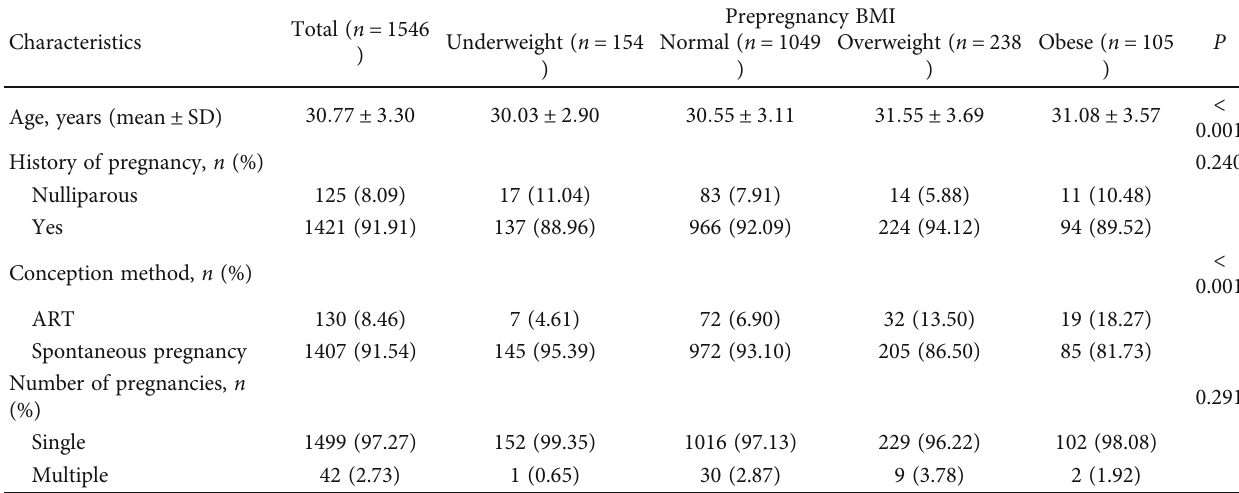
Table 1: Baseline characteristics of the study participants.